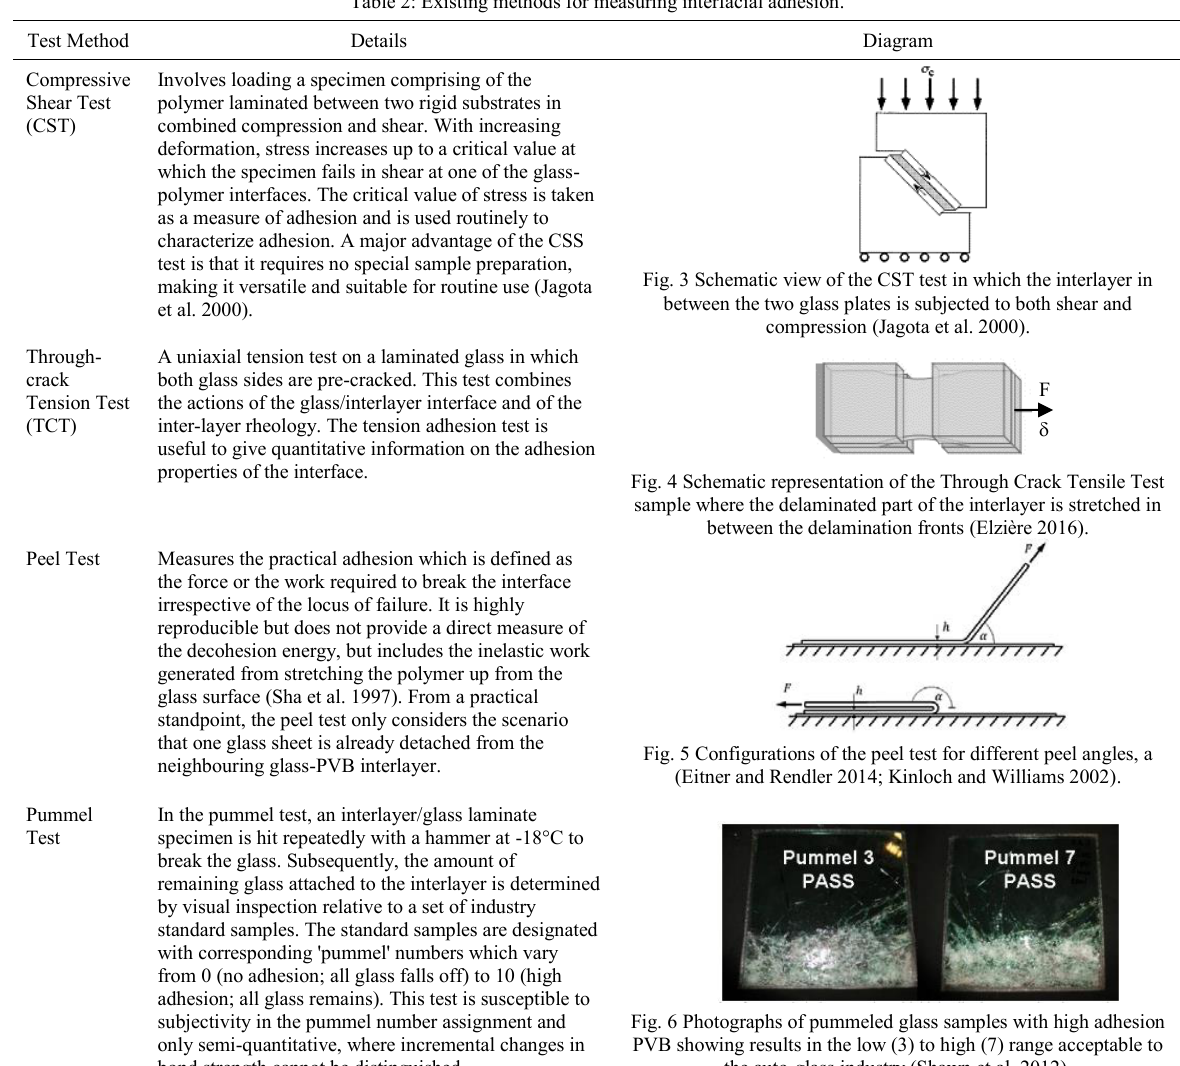
Fig. 6 Photographs of pummeled glass samples with high adhesion PVB showing results in the low (3) to high (7) range acceptable to the auto-glass industry (Shawn et al.